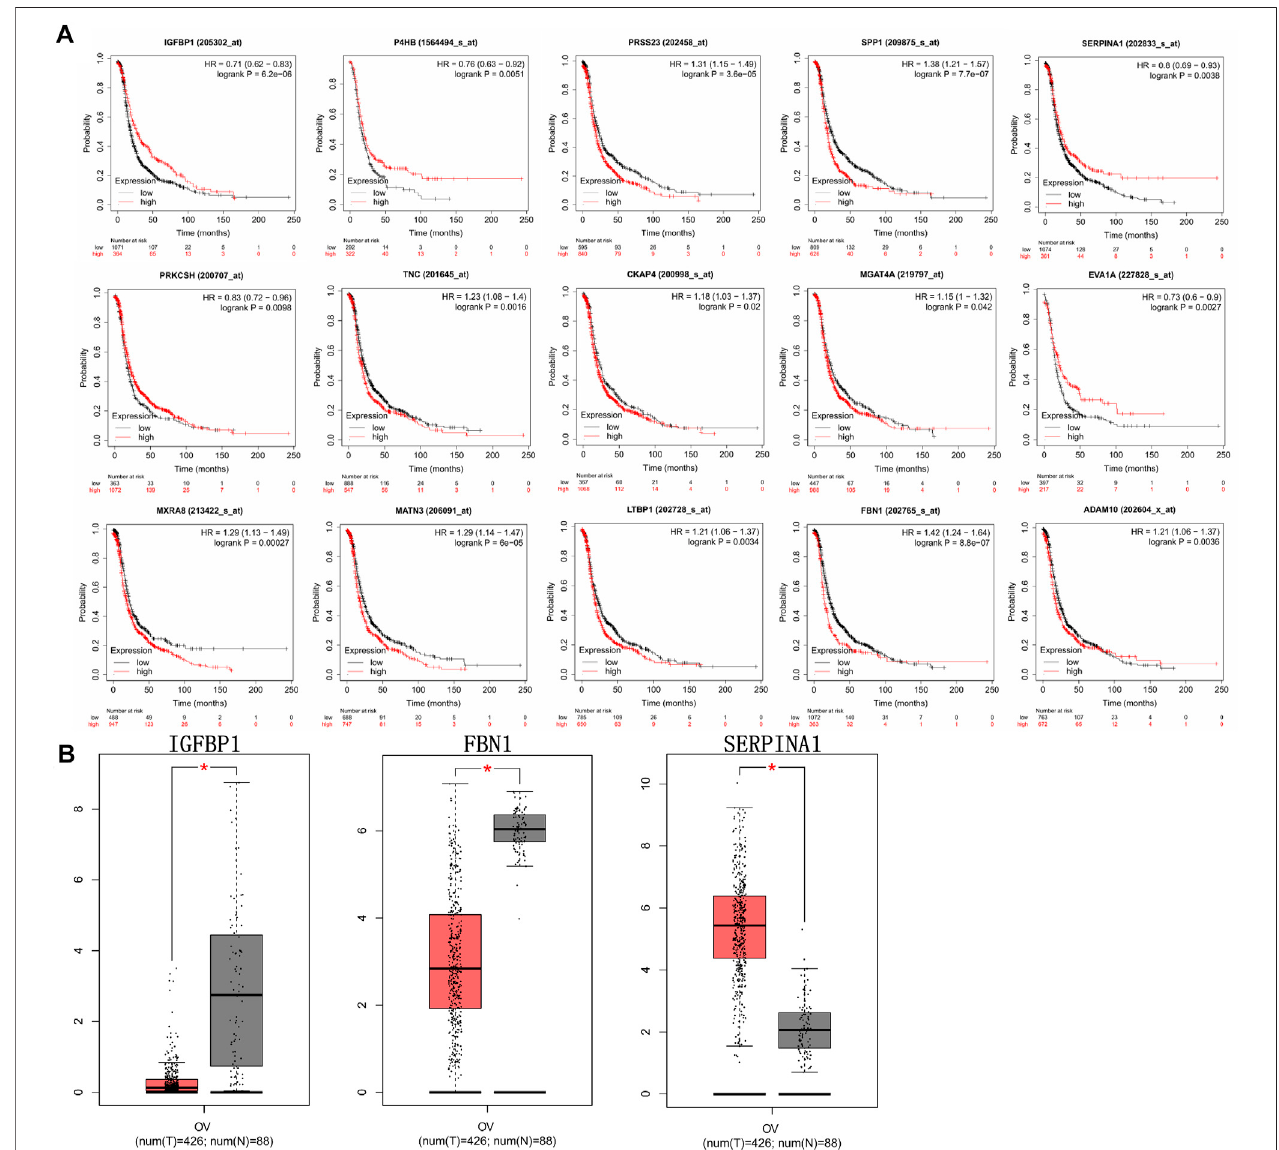
FIGURE 6 | Prognostic information and expression level analysis of hub genes. (A) The prognostic information of 18 hub genes was analyzed by Kaplan-Meier plotteronlinetools,and16ofthe18genesweresigni fi cantlyrelatedtotheprognosisofovariancancer( p < 0.05). (B) Theexpressionlevelsofhubgenesbetweenovarian cancer tissues and normal tissues were analyzed through the GEPIA database. Compared with normal tissues, 3 of the 16 genes were signi fi cantly differentially expressed in ovarian cancer tissues (* p < 0.05). Red represents tumor tissue; gray represents normal tissue.